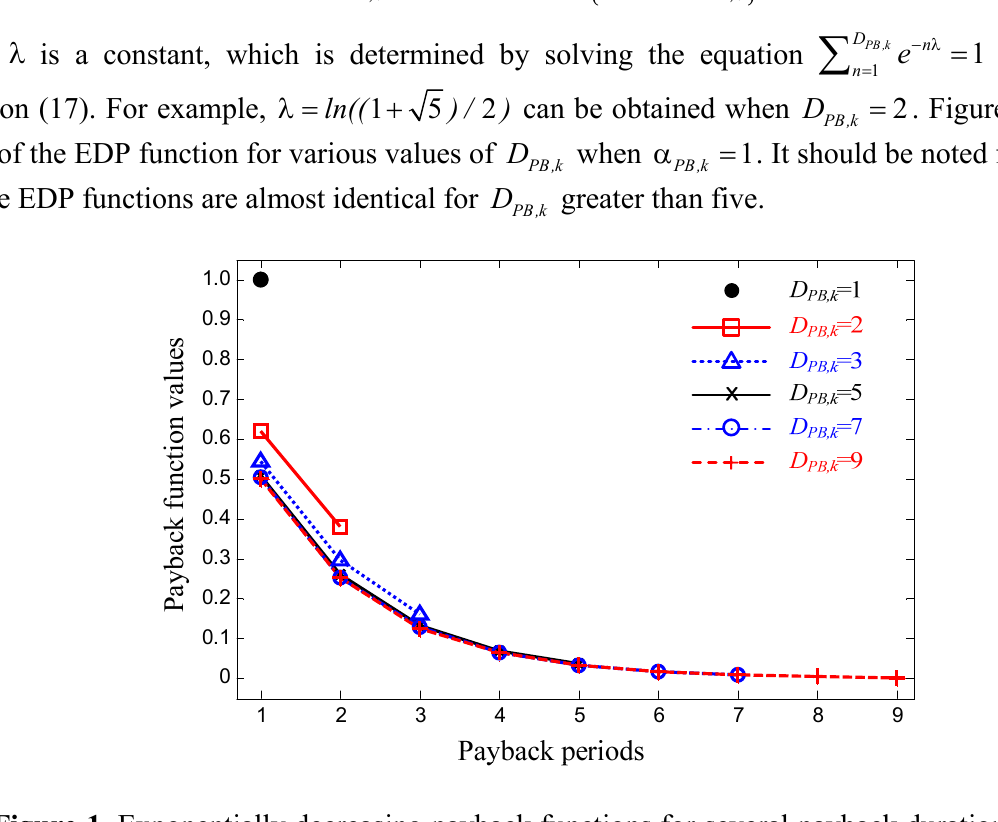
Figure 1. Exponentially decreasing payback functions for several payback duration values of 1, 2, 3, 5, 7, and